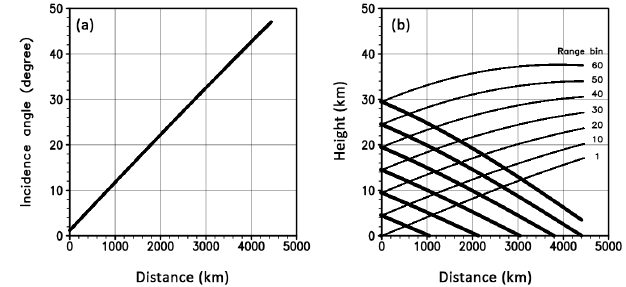
Figure 5. Incidence angle (a) and height of the radar scattering vol- ume (b) as a function of the distance from the nadir. Thick and thin lines in (b) show the lower and upper bound,